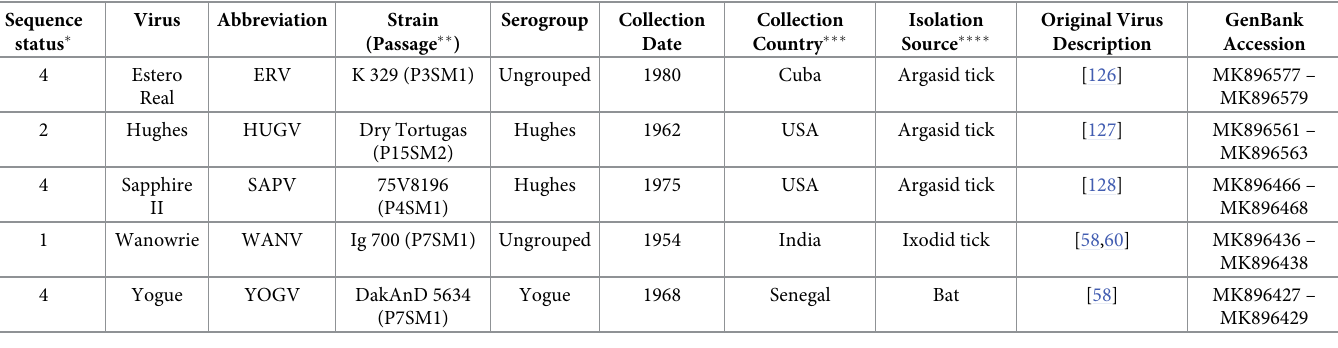
Table 3. Sequenced genomes of 5 viruses belonging to Nairoviridae (Orthonairovirus)